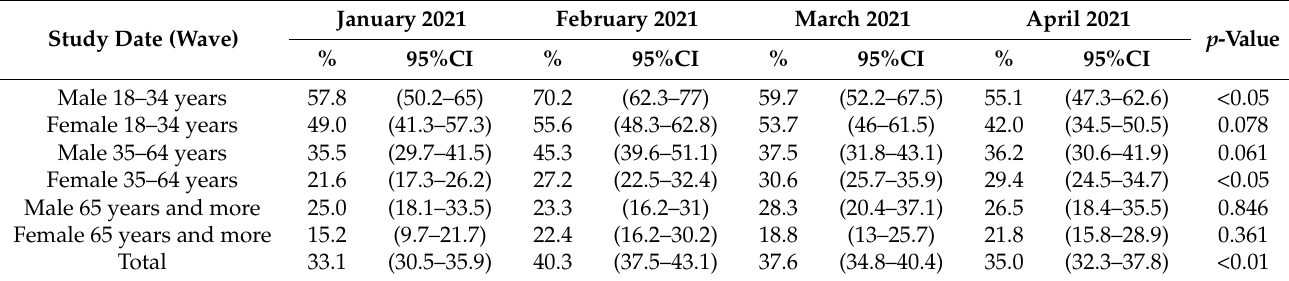
Table 3. Percentage of respondents who declared lack of fear of SARS-CoV-2 coronavirus infection in Poland by gender and age, January–April 2021.